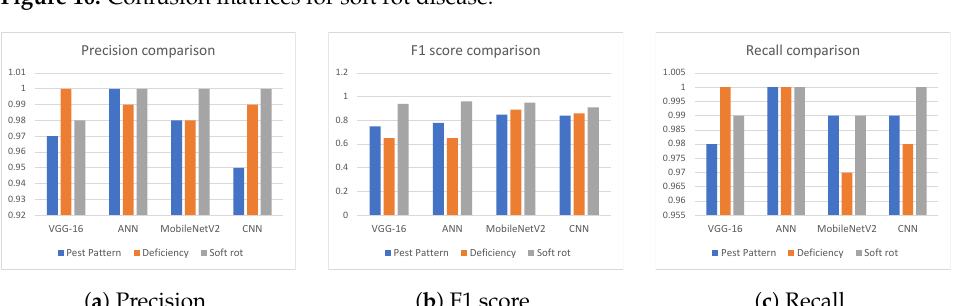
Figure 16. Confusion matrices for soft rot disease.